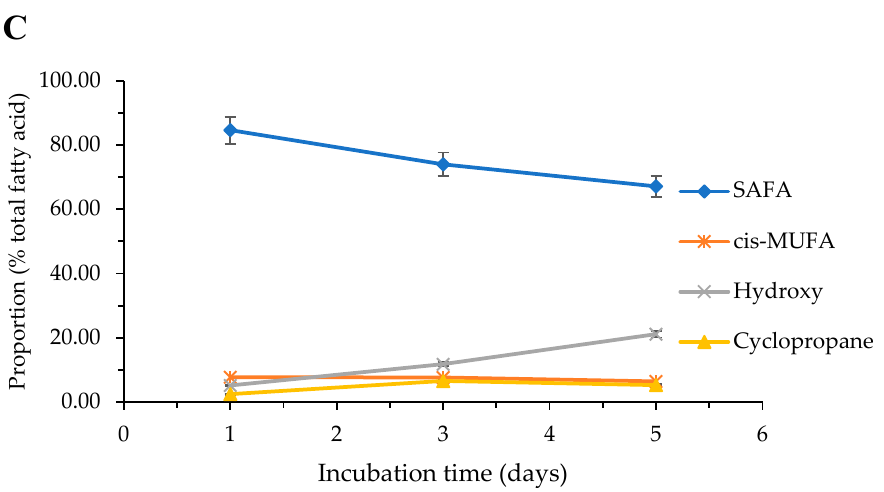
Figure 5. Influence of incubation time on the fatty acid proportion of P. aeruginosa ATCC 27853 grown at ( A ) 25 ◦ C, ( B ) 37 ◦ C and ( C ) 42 ◦ C, using blood agar culture media (mean ± SD; n = 3). The optimized experimental conditions are detailed in Section